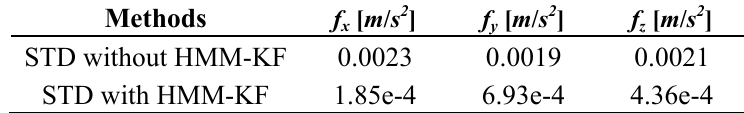
Table 2. STD of accelerometer outputs with and without HMM-KF.